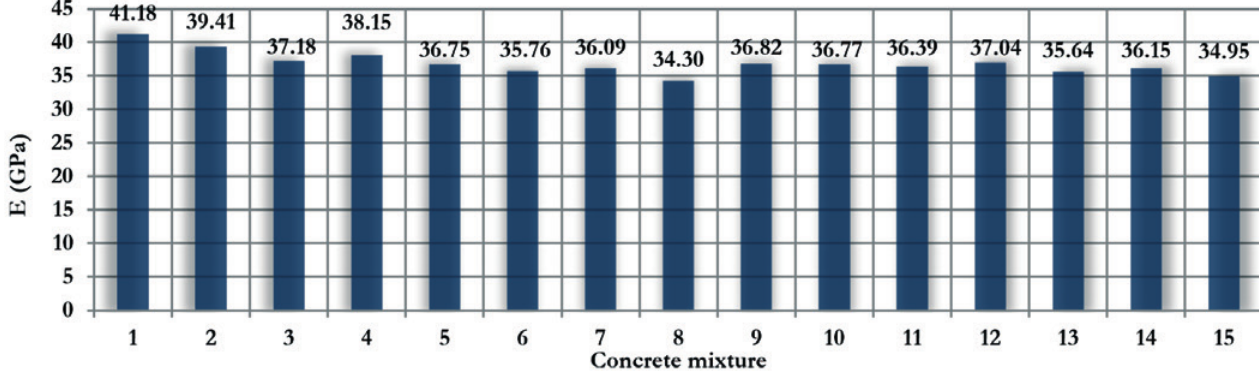
were not measured. The test set-up is shown in Figure 4.